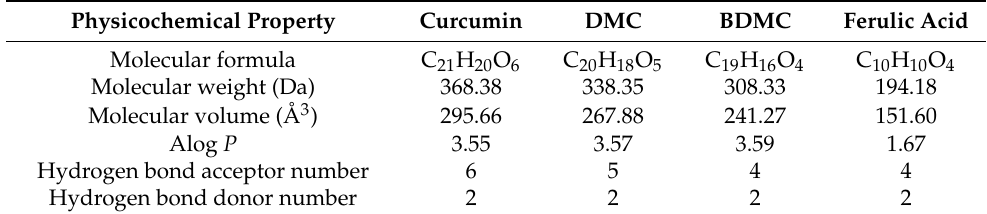
Table 1. Physicochemical properties of curcumin and its derivatives determined by molecular